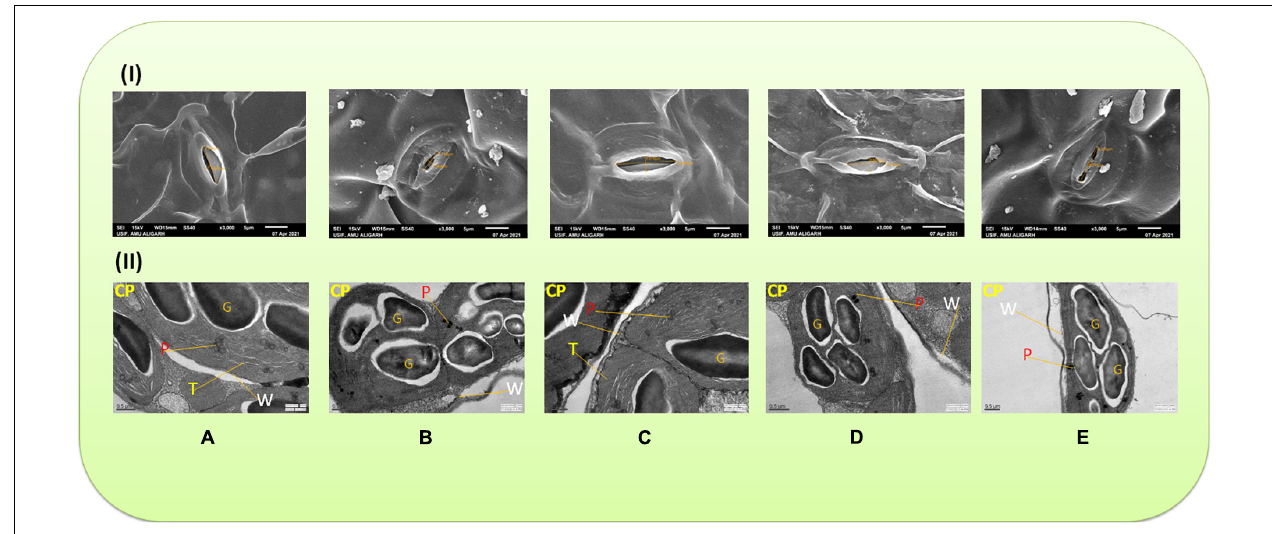
FIGURE 1 | (I) Scanning electron microscope (SEM) images of stomata in 45 day-old leaves of Brassica juncea (L.) cv. Varuna raised with Cu and/or sprayed with melatonin (MEL) at 3,000 × magnification. (A) Control, (B) Cu 60 mg kg − 1 , (C) MEL 40 µ M, (D) Cu 30 + MEL (40 µ M), and (E) Cu 60 + MEL (40 µ M). (II) Transmission electron microscope (TEM) images of chloroplast in 45 day-old B. juncea (L.) cv. Varuna raised with Cu and/or sprayed with MEL. (A) Control, (B) Cu 60 mg kg − 1 , (C) MEL 40 µ M, (D) Cu 30 + MEL (40 µ M), and (E) Cu 60 + MEL (40 µ M). CP, chloroplast; T, thylakoid; P, plastoglobuli; G, omniferous granules; W, cell